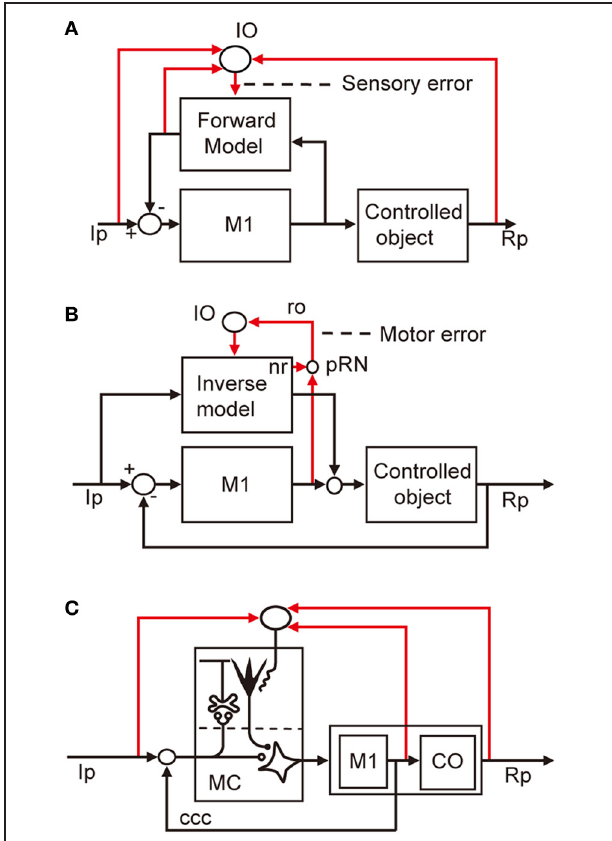
FIGURE 5 | Models for voluntary motor control. (A) Forward-model- based control of arm movement by primary motor cortex. (B) Inverse-model-based control. (C) Application of reflex control scheme. Additional abbreviations: ccc, cerebrocerebellar communication loop. CO, control object including segmental circuit and skeletomuscular system; MC, microcomplex, M1, primary motor cortex; IO, inferior olive; Ip, instructed performance; Rp, realized performance; ro, rubroolivary pathway; pRN, parvocellular red nucleus; nr, nucleorubral